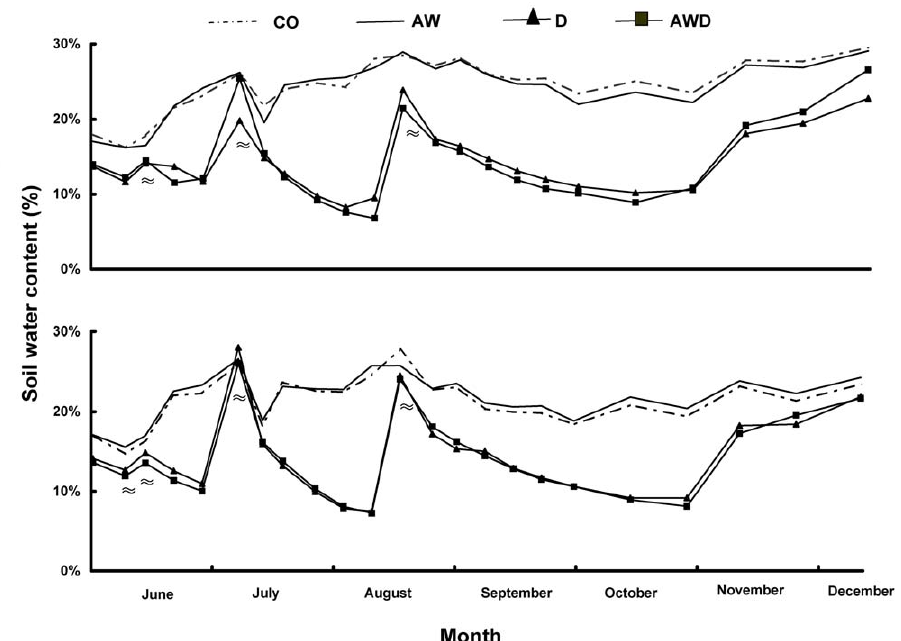
Figure 1. Effects of climate treatments and soil types on soil water content. Soil water content (SWC) at a depth of 0–25 cm in acid (A) and calcareous (B) soils as affected by the treatments: CO=control, AW=air warming, D=drought, and AWD=air warming + drought. Values are means of four plots in 2007. < indicates no significant drought effects between (CO and AW) and (D and AWD) (n=4).